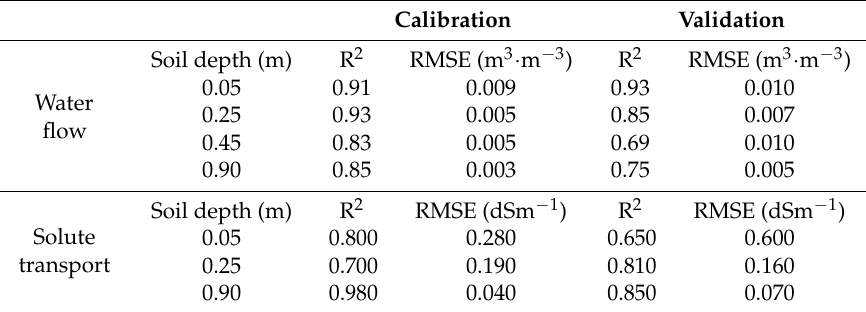
Table 3. Model performance